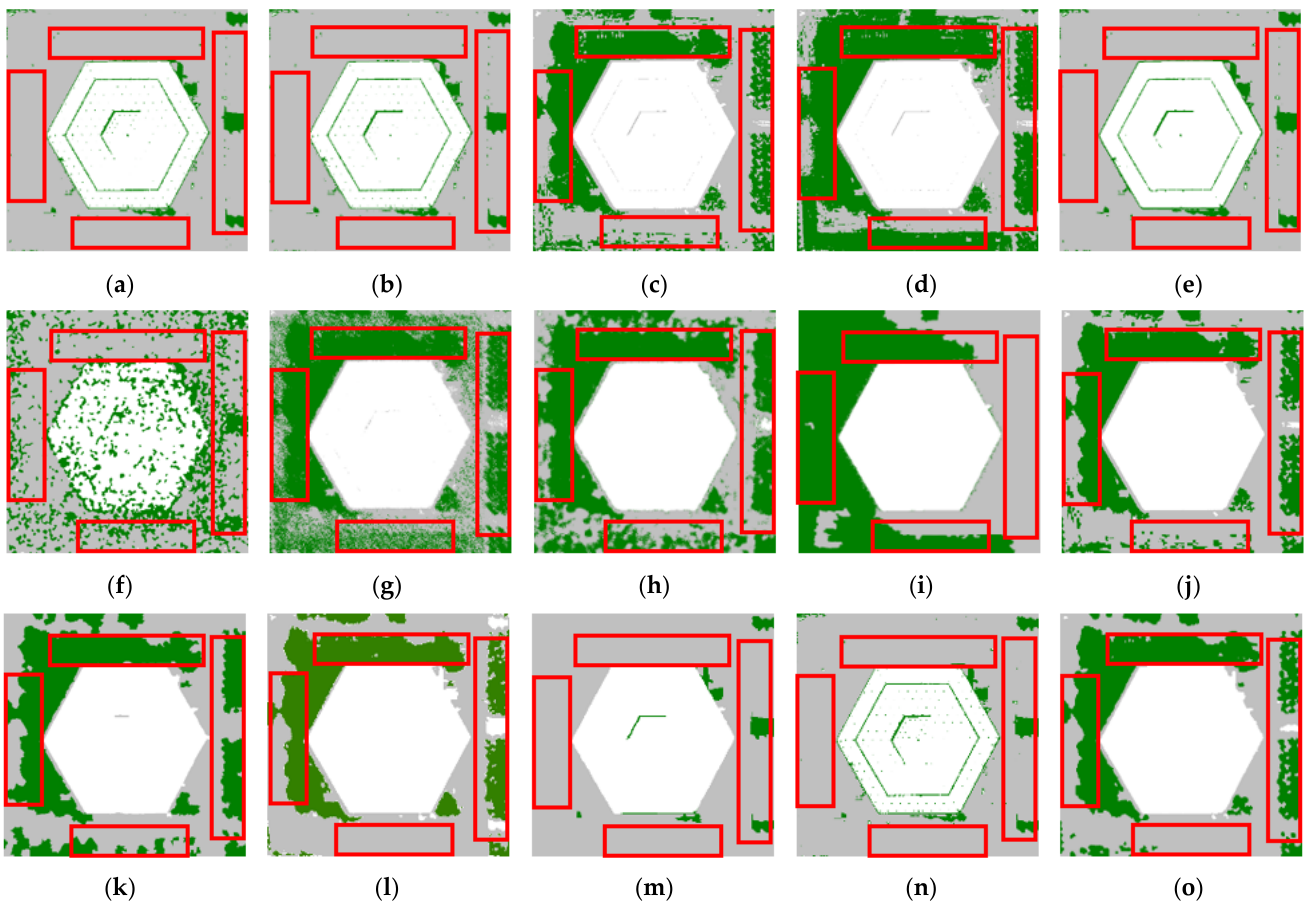
Figure 4. Experiment results of S1 images. The red rectangle boxes are selected as the comparison areas. ( a ) S1 K-means, ( b ) S1 ISODATA, ( c ) S1 FCM, ( d ) S1 IFCM, ( e ) S1 FLICM, ( f ) S1 HMRF-FCM, ( g ) S1 FCM_S, ( h ) S1 FCM-SICM, ( i ) S1 SFFCM, ( j ) S1 FRFCM, ( k ) S1 SPFCM, ( l ) S1 SBPNN, ( m ) S1